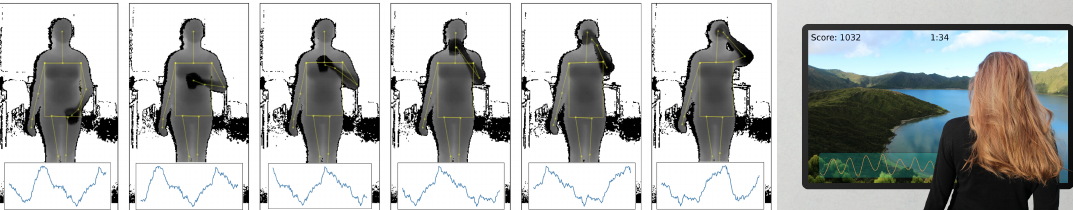
Figure 1. Left: Our approach estimates the breathing signal and rate of a user, using body posture data and the raw depth signals from a depth camera in the environment. The user is assumed to be indoors and facing the camera, for instance while performing activities guided by a display, but can be anywhere in the frame, upright or sitting, and she can perform activities that self-occlude the torso. Right: An example application with the user performing a relaxation exercise with guided respiration while her breathing is tracked and evaluated over